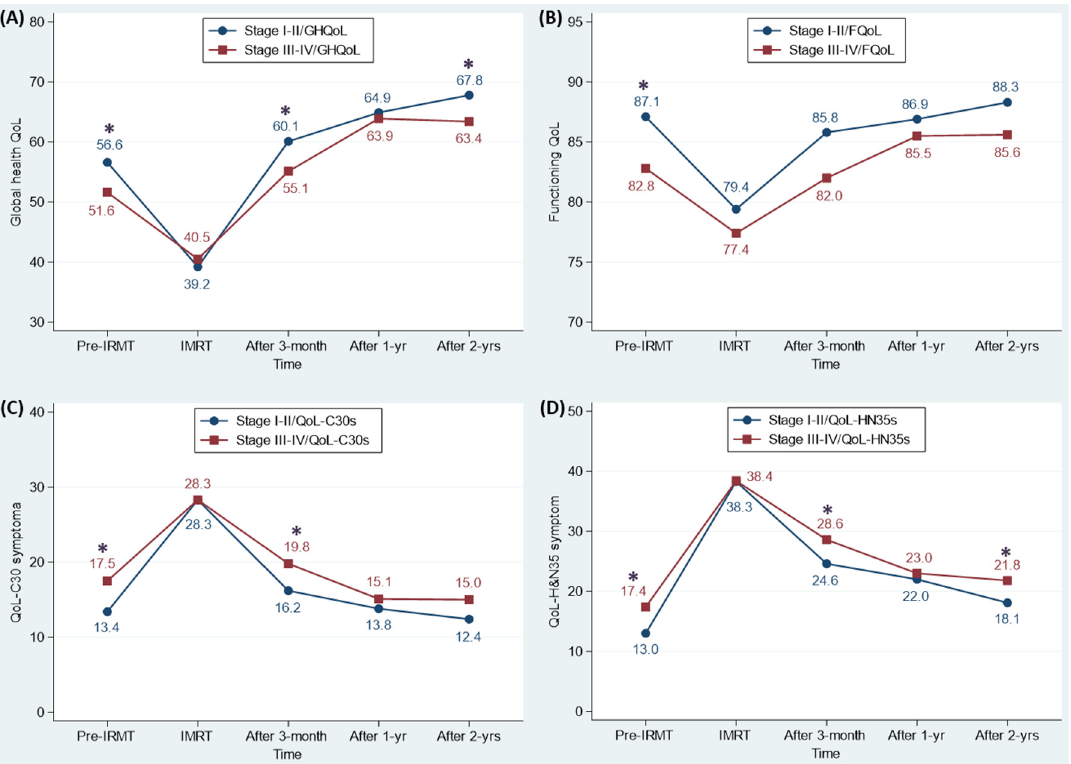
Figure 2. Distributions of adjusted quality of life (QoL) mean scores associated with AJCC stage (I–II/III–IV) at different intensity-modulated radiotherapy (IMRT)-related time points for nasopharyngeal cancer patients. ( A ) Global health QoL; ( B ) Functioning QoL; ( C ) QoL-C30 symptom; ( D ) QoL-HN35 symptom. Note: The investigated time periods included